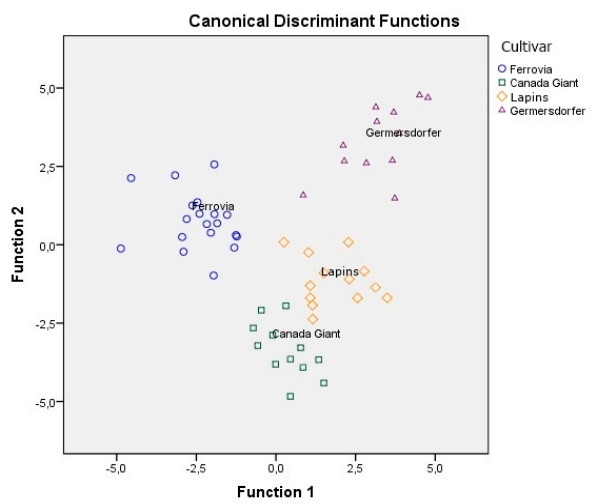
Figure 1. Differentiation of four cultivars based on the combination of volatile compounds and conventional quality parameters.